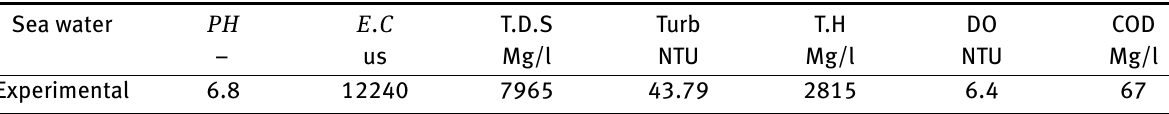
Table 4: Properties and chemical compounds of sea water Sea water